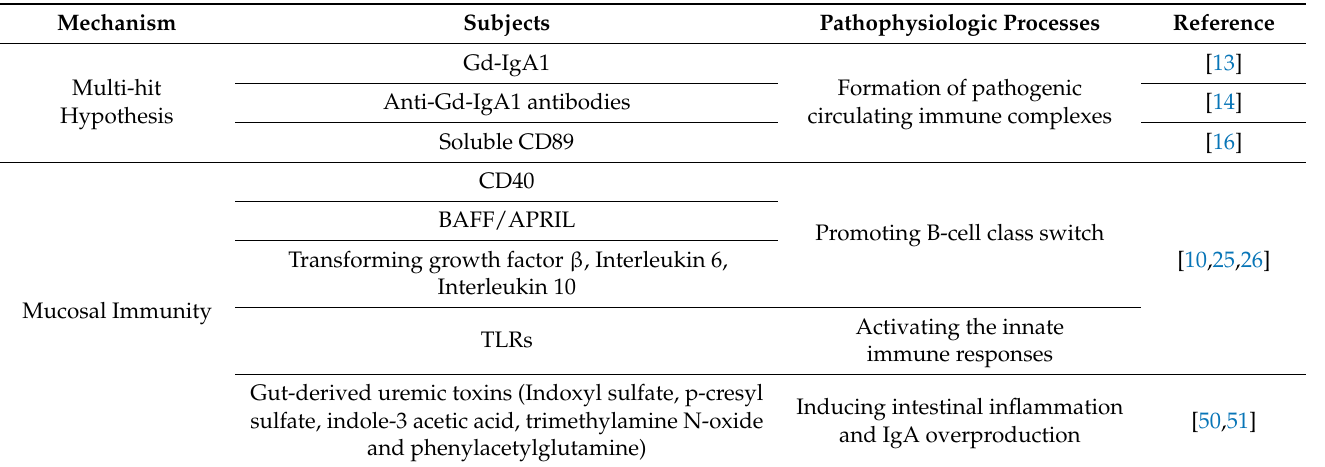
Table 1. Molecules involved in the pathogenesis of